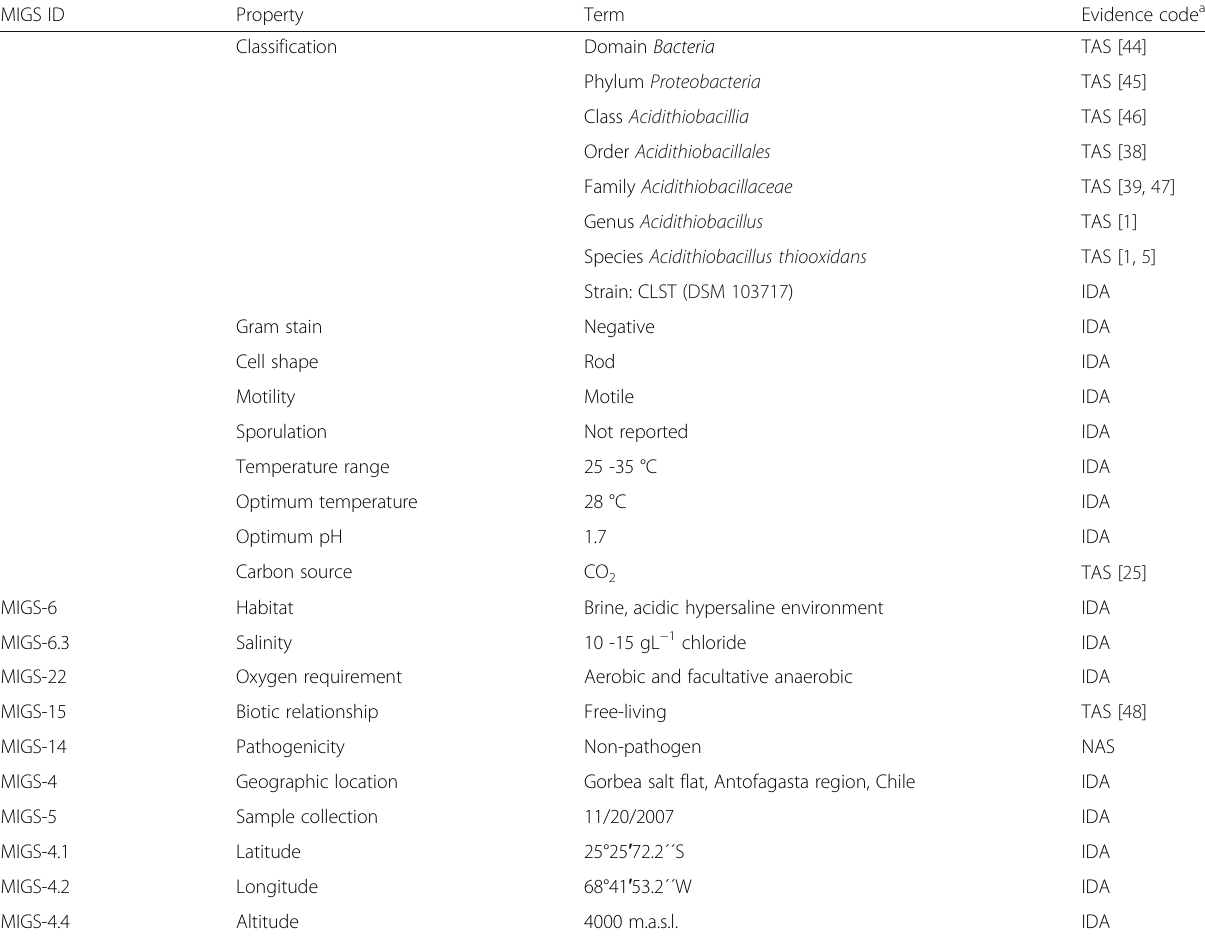
Table 1 Classification and general features of A. thiooxidans